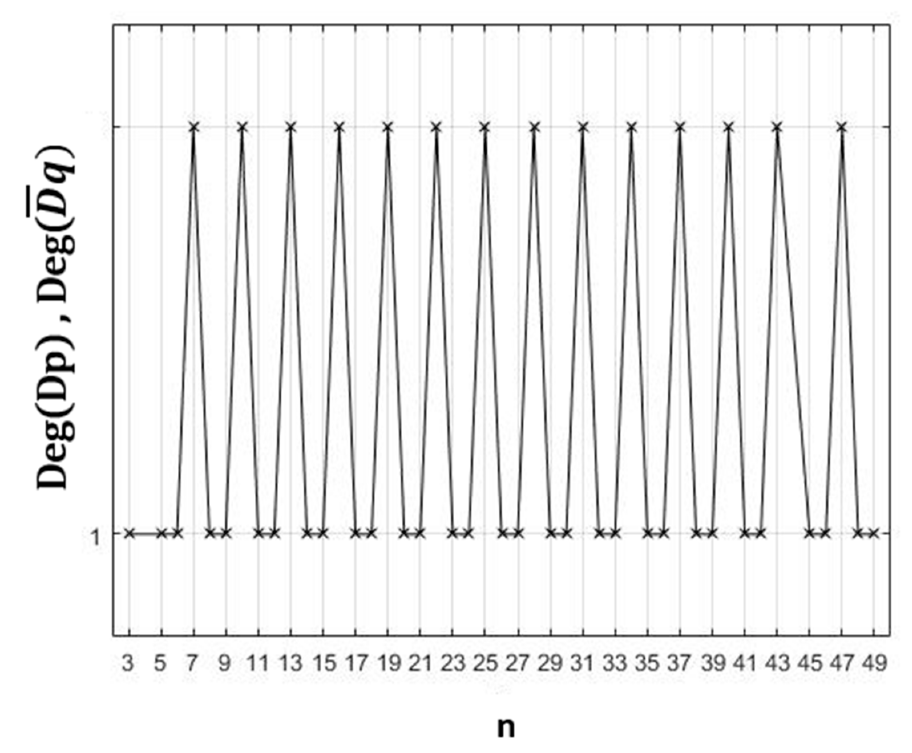
Figure 7. Variation of the degrees of degeneracy deg(D p ) and deg( D q ) corresponding to the least Figure 8. Variation of the degrees of degeneracy deg(D p ) and deg( 𝐷(cid:3365) q ) corresponding to the least degenerate domains. degenerate domains.